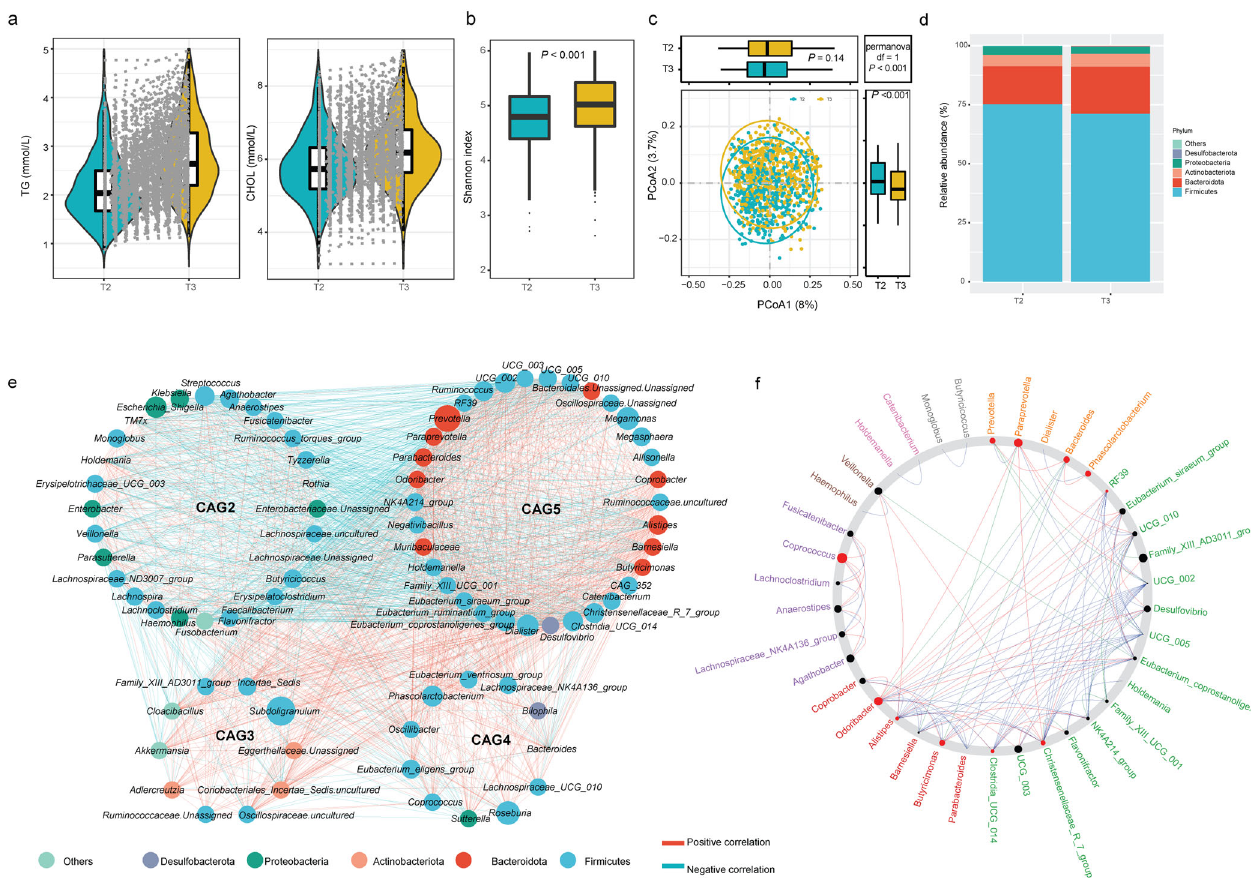
Fig. 2 Dynamic change of lipid levels and gut microbiota structure during pregnancy. a Violin plots showing the TG and CHOL levels during pregnancy. The dotted lines indicated the trend of change within the participant. b Boxplots showing the change of alpha diversity indexes during pregnancy. The center line denoted the median. The boxes covered the 25th and 75th percentiles, and the whiskers extended to the most extreme data point, which was no more than 1.5 times the length of the box away from the box. Points outside the whiskers represented outlier samples. P values in the plots showed P obtained from the Wilcoxon rank-sum test. c Change of beta diversity indexes during pregnancy. The center line denoted the median. The boxes covered the 25th and 75th percentiles, and the whiskers extended to the most extreme data point, which was no more than 1.5 times the length of the box away from the box. Points outside the whiskers represented outlier samples. P values in the boxplots and blank squares showed P obtained from the Wilcoxon rank-sum test and PERMANOVA test, separately. d Comparison of relative abundance of phylum. e Network plots of genera in participants during pregnancy. Each node represented a genus. The size of each node correlates to the mean abundance of each genus across all samples. Nodes were shown if the abundance of the respective genus was signi fi cantly correlated with each other (FDR < 0.05). Red line: positive correlation; Blue line: negative correlation. Each node was colored according to its phylum. f Most common sub-network between the T2 and T3 network. All nodes belonging to the same community were randomly assigned a same color. Grayed-out nodes represented the ones present in both but directly interacted with the common sub-network in either T2 or T3. Node sizes were proportional to their scaled NESH score, and a node was colored red if its betweenness increased from T2 to T3. Hence, big and red nodes were particularly important ‘ drivers ’